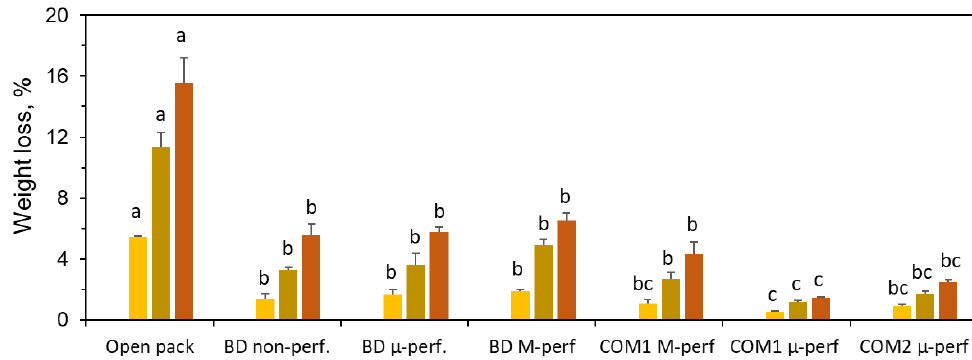
Figure 4. The effect of packaging methods on the weight loss of banana fruit after 3 days of simulated distribution at 15 °C and 1, 3 or 5 days of shelf life/home storage at 24 °C. Package designations are the same as in Figure 2. Error bars represent standard errors of three replications. Within each sampling day, different letters above the bars indicate significant differences between packaging types at p ≤ 0.05, according to Tukey’s HSD test.